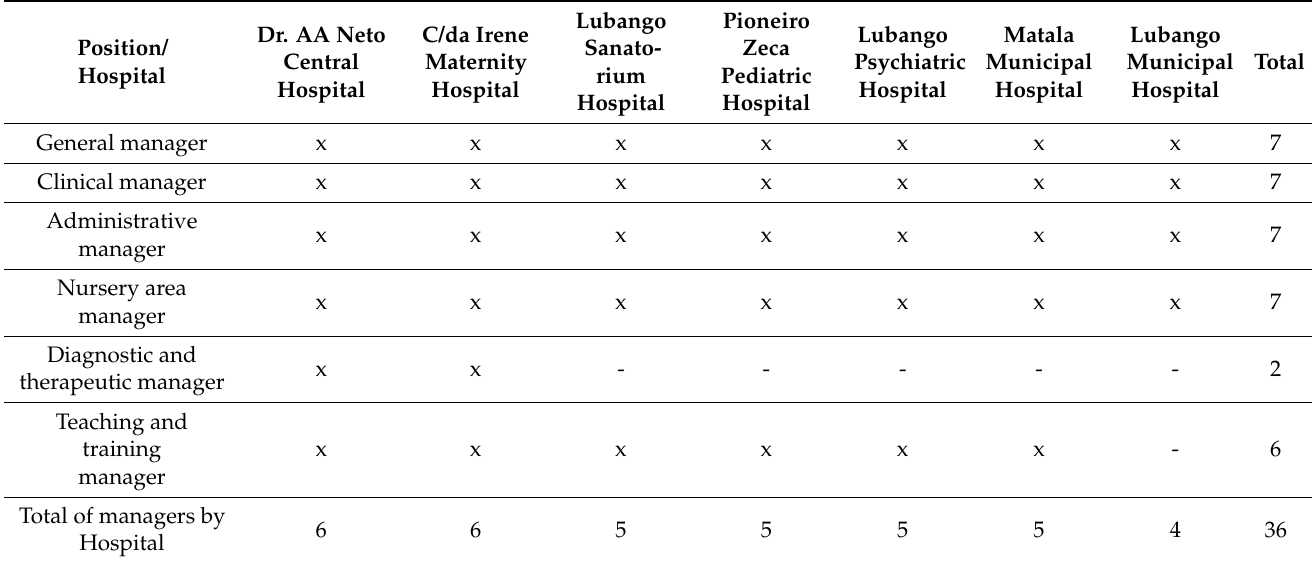
Table 1. Hospital managers interviewed in each